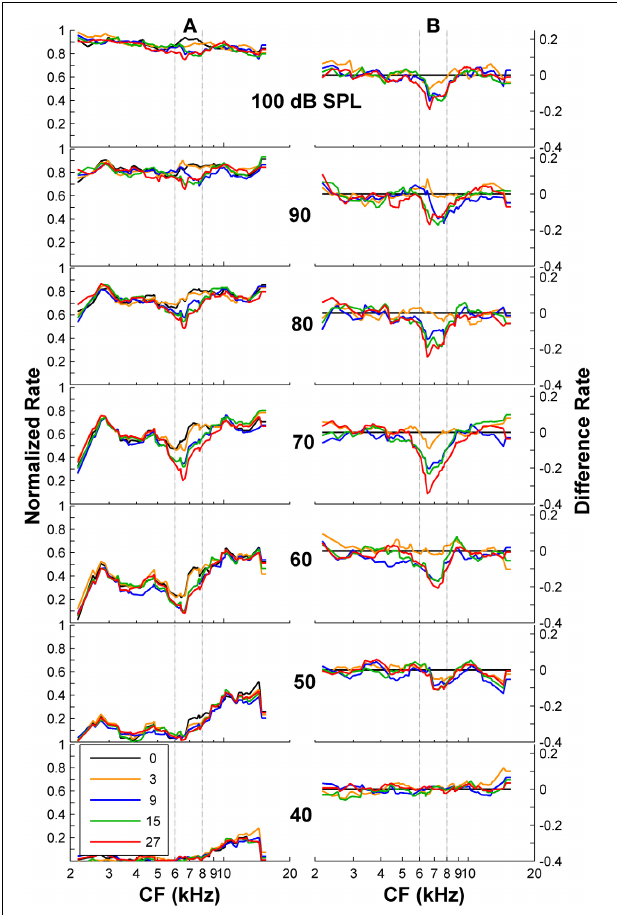
FIGURE 4 | Auditory nerve data: rate profiles for different overall noise levels and for different notch depths. (A) Normalized rate profiles. Each curve is for a different notch depth (in dB), as indicated by the inset. (B) Difference between the rate profiles for the flat-spectrum and the notched noises. The numbers in the inset denote notch depths in dB re spectrum level of the notch side bands. Vertical dashed lines illustrate the frequency band of the spectral